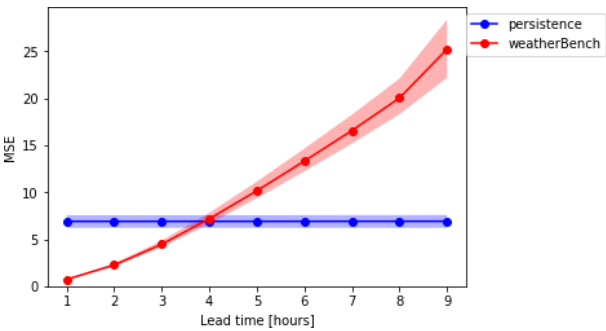
Figure C1. MSE over 9h forecast for 2m temperature with inter- decile bootstrap confidence intervals (shading area) using Weather- Bench convolutional neural network and persistence